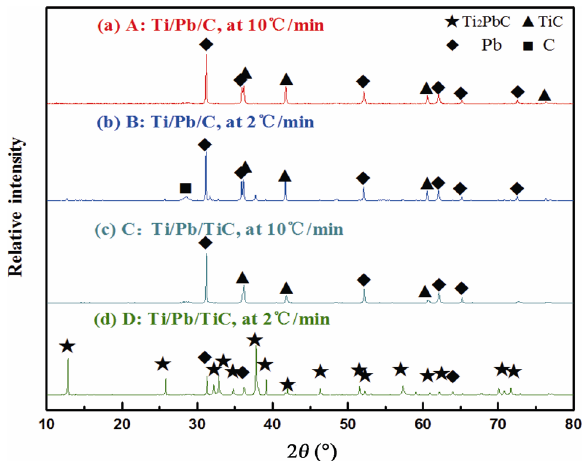
Fig. 1 XRD patterns of (a) sample A from Ti/Pb/C at 10 ℃ /min; (b) sample B from Ti/Pb/C at 2 ℃ /min; (c) sample C from Ti/Pb/TiC at 10 ℃ /min; (d) sample D from Ti/Pb/TiC at 2 ℃ /min. All samples were synthesized at 1370 ℃ .